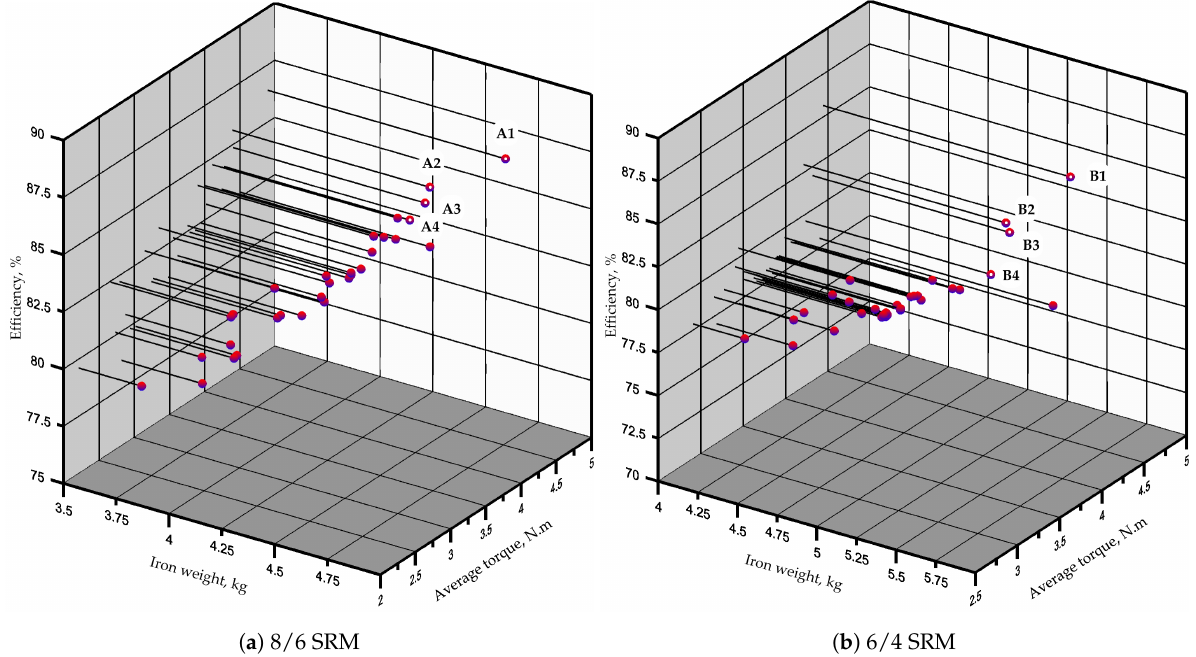
Figure 6. Objective functions 3D representation of the last generation (30 candidates).